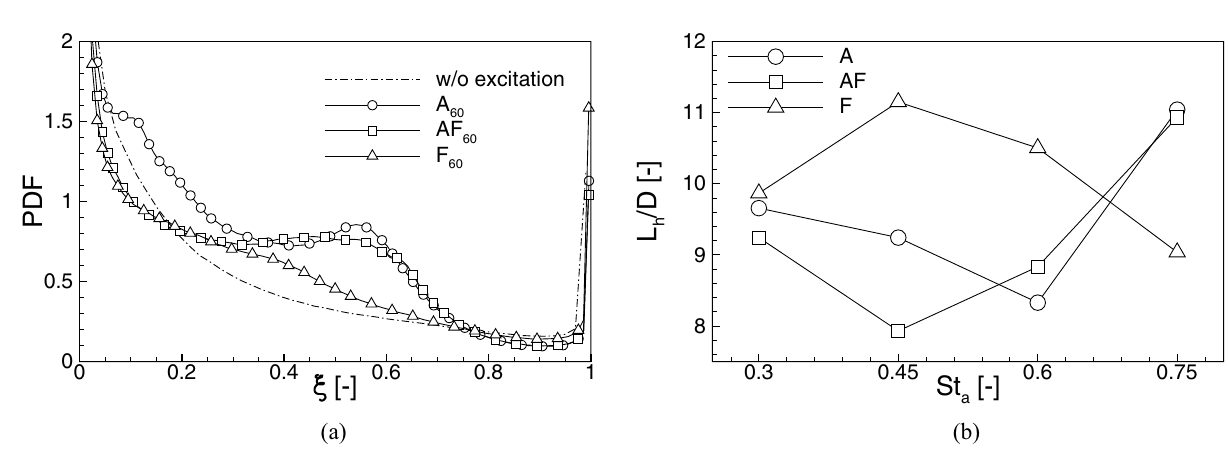
Figure 6. PDF of the mixture fraction ( a ) and the lift-off height of the flames ( b